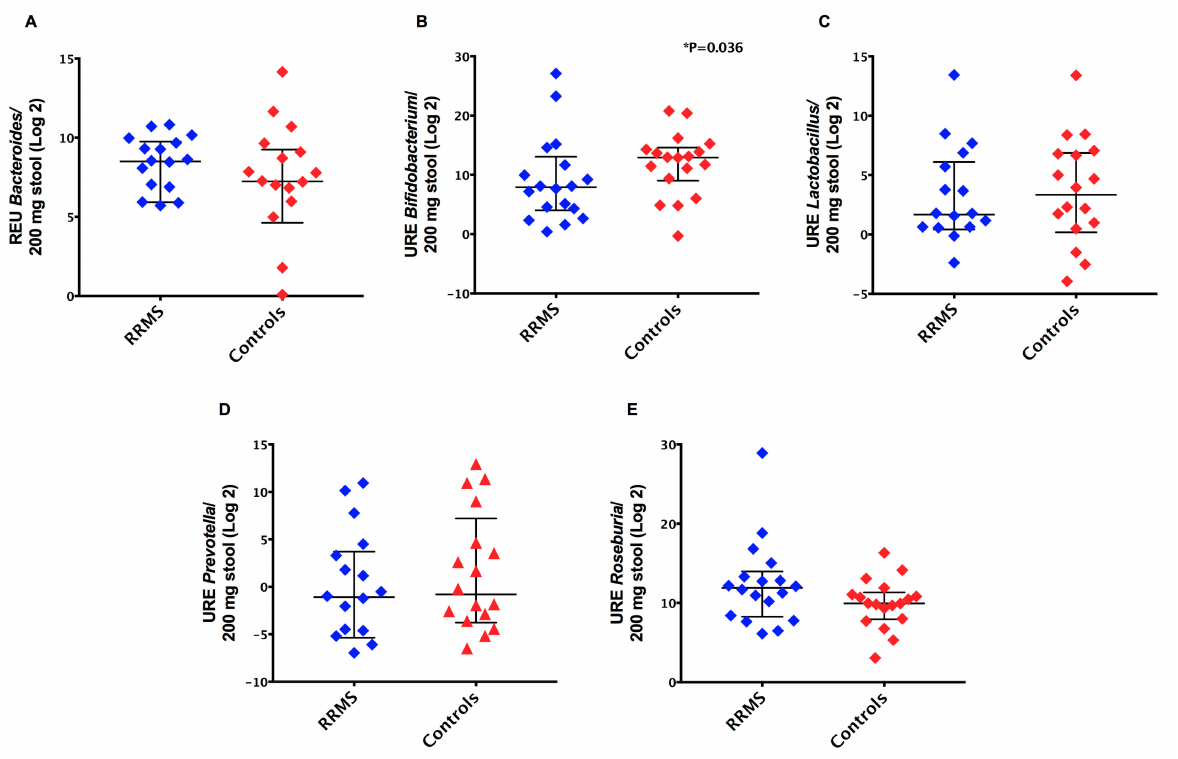
Figure 3. Relative abundance of bacterial community in stool samples from RRMS patients and controls. ( A ) Bacteroides species, ( B ) Bifidobacterium species, ( C ) Lactobacillus species, ( D ) Prevotella species, and ( E ) Roseburia species. Bars represent the median with interquartile range of relative expression units (REU) per 200 mg of